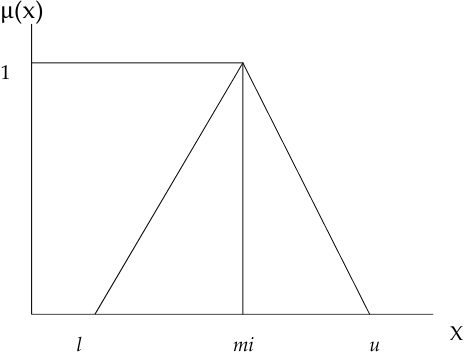
Figure 2. Triangular fuzzy number.